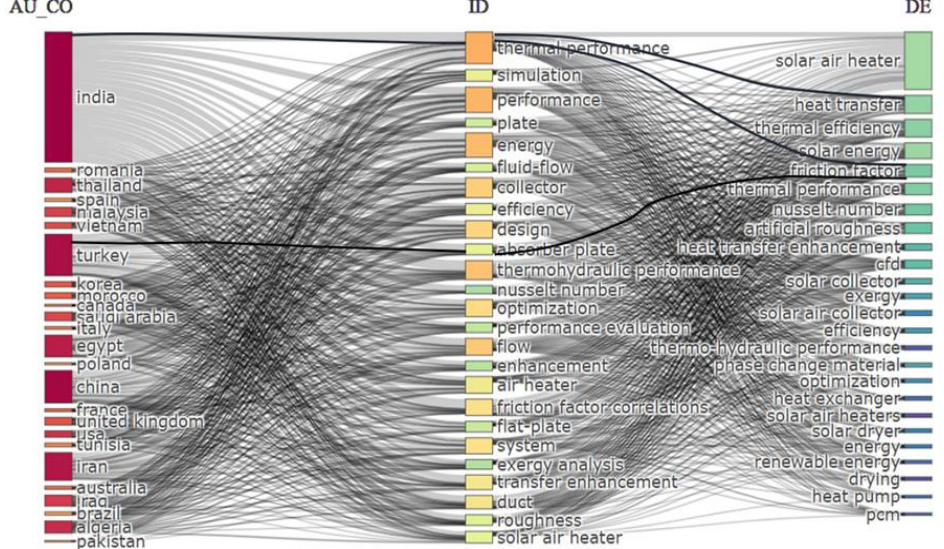
Figure 12. Sankey diagram for solar air